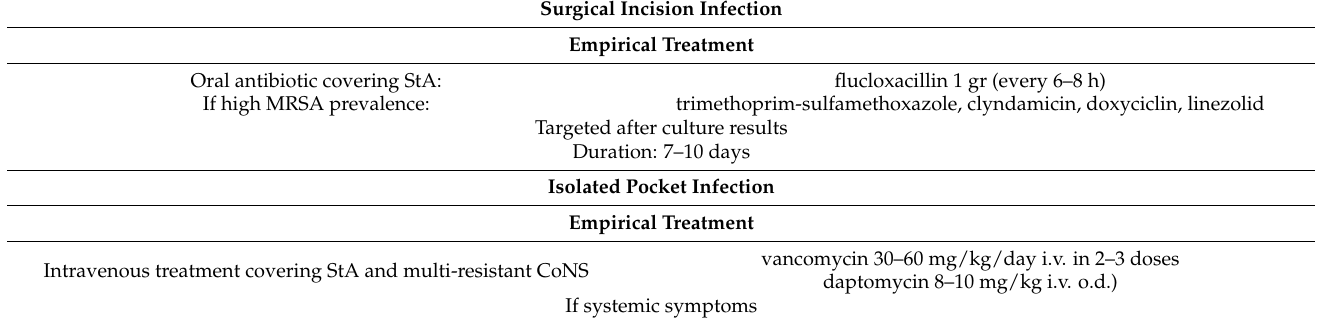
Table 2. Antibiotic treatment